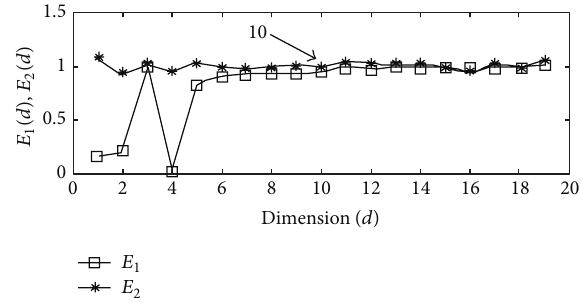
Figure 17: Vibration signal.